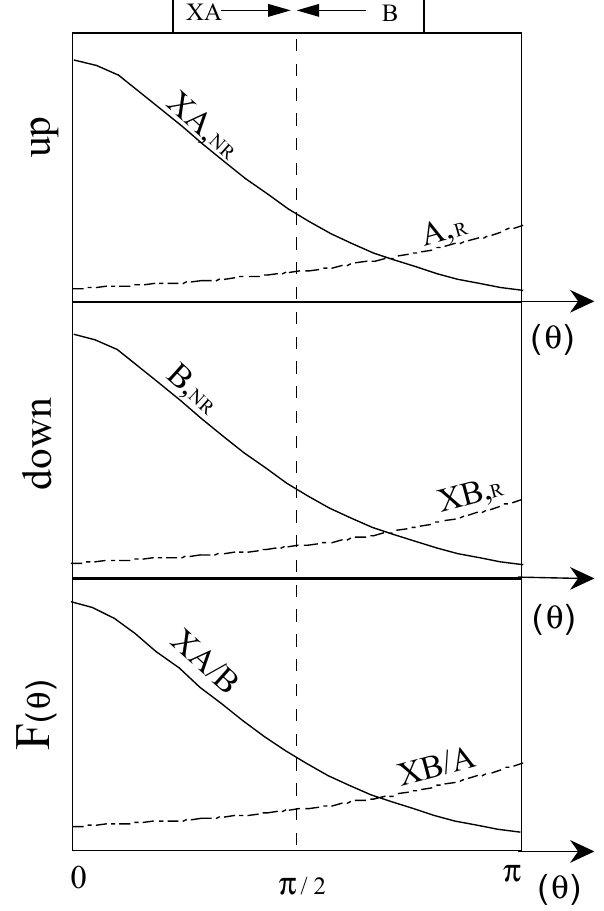
NON REACTIVE Figure 1a